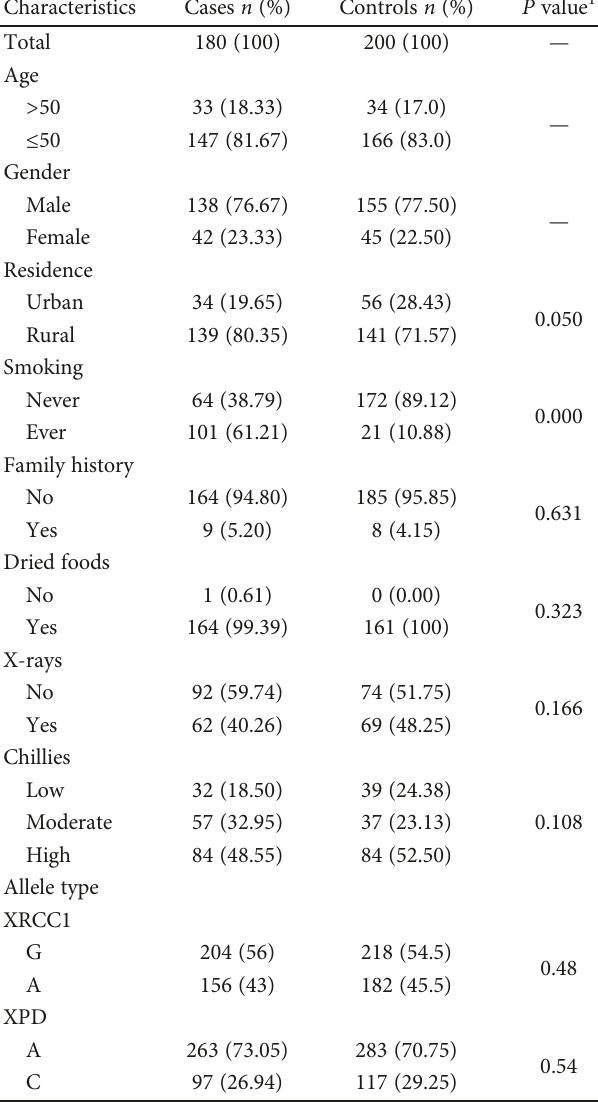
Table 1: Demographic characteristic of gastric cancer cases and